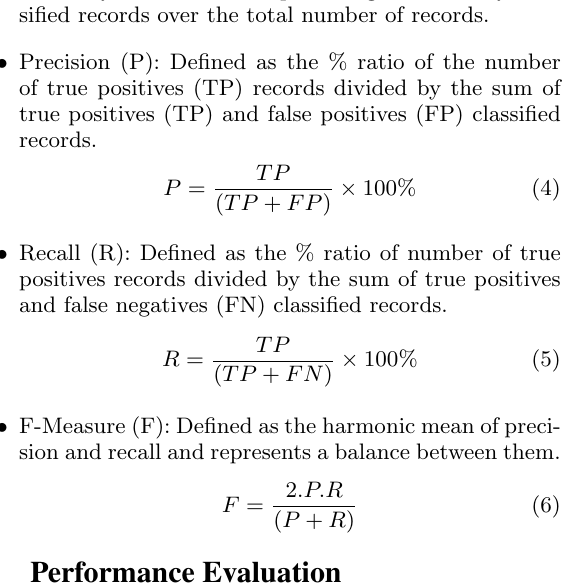
Figure 2: Various steps involved in our NIDS imple-